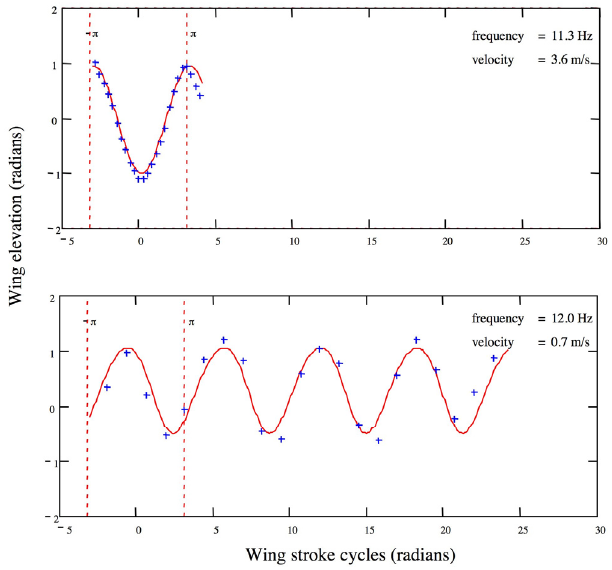
Figure 2. Fourier reconstruction of wing strokes. At the top, a single wing stroke of a H. sara filmed at 250 fps. Below, multiple wing strokes of a butterfly filmed at 60 fps. Wing elevation is 0 radians when horizontal. Blue crosses: raw data, red lines: best-fitting Fourier transform of the data.